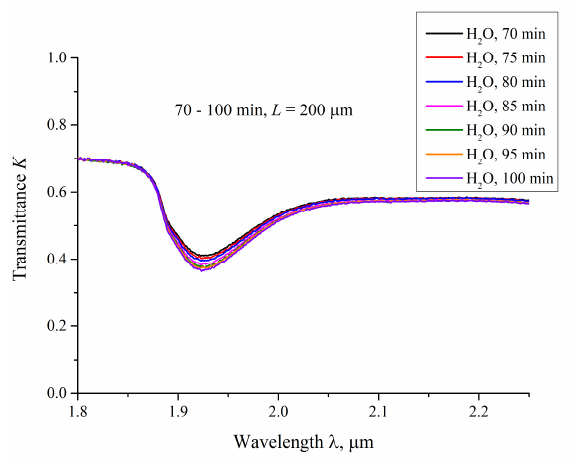
Figure 6. The transmittance spectra in the range 1.8 < λ < 2.2 µ m for the case of swelling Nafion in ordinary water; the distance between the windows is L = 200 µ m, and the curves are related to the swelling times 70, 75, 80, 85, 90, 95 and 100